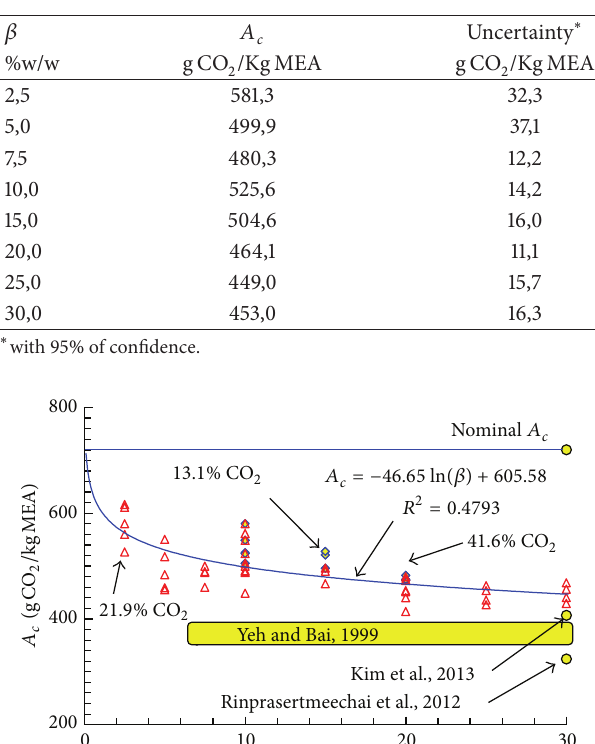
Table 2: CO 2 absorbing capacity of MEA at 25 ∘ C and 101.3kPa.